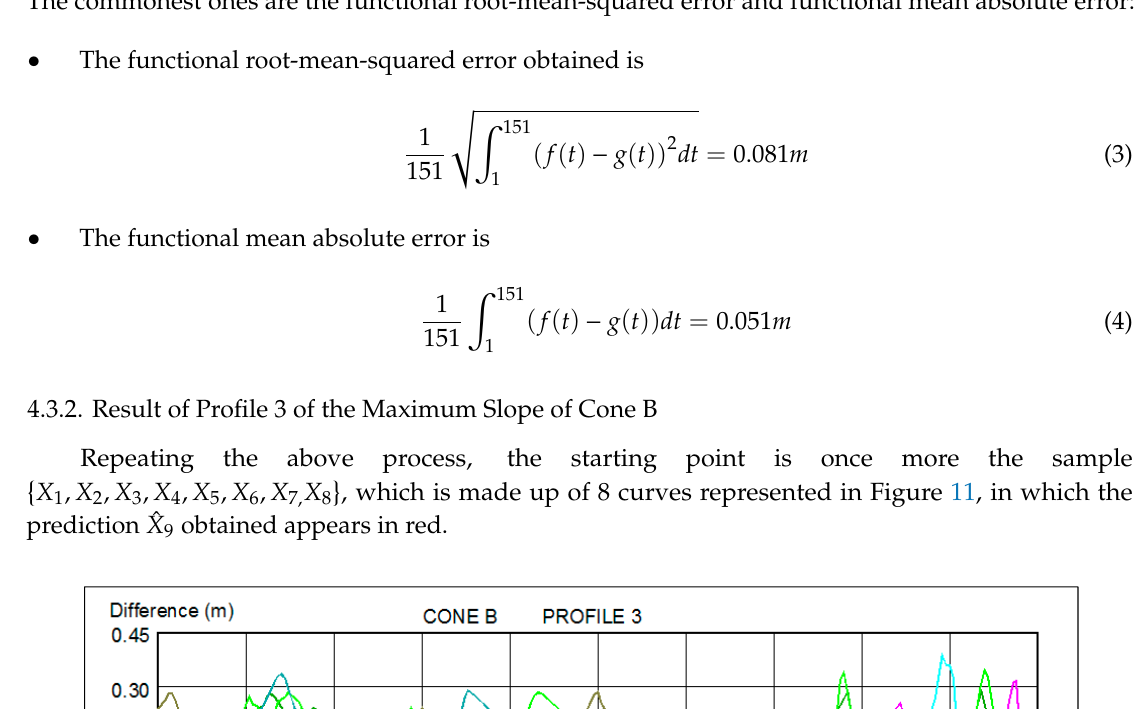
Figure 10. Representation of the difference between two results: The data are obtained as a prediction of 2018 and the real measured values of 2018 from profile 3 of Cone A. There are di ff erent measurements of error between the curve obtained by prediction and reality. The commonest ones are the functional root-mean-squared error and functional mean absolute error: